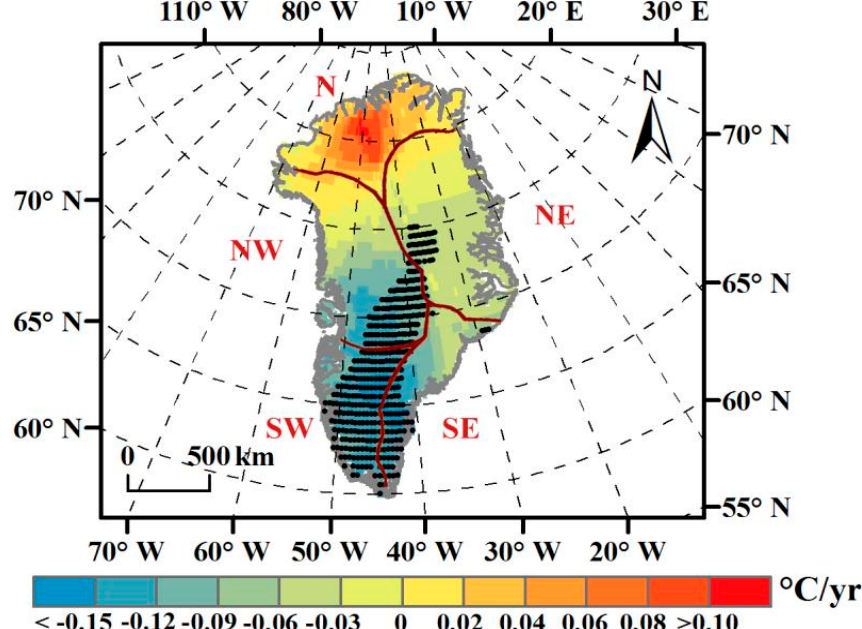
Figure 7. Spatial distribution of annual change trend of GHCN CAMS land surface temperature in Greenland from 2003 to 2015. Note: Lattice point representation passed the M–K test of 95% confidence interval.